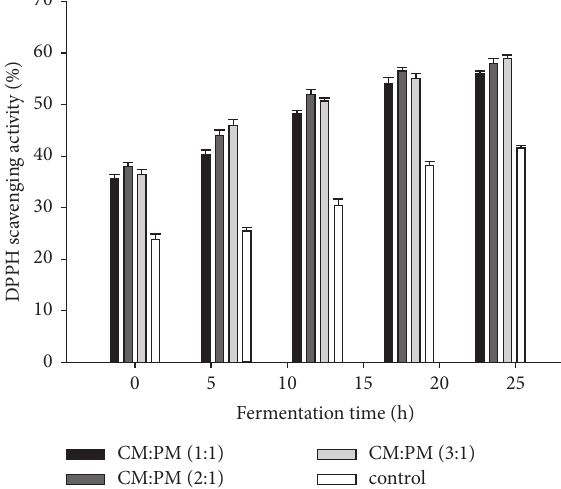
Figure 5: DPPH free radical scavenging rate of four samples at different fermentation times. All the values are expressed as mean ± SD ( n � 3). CM, cowpea milk; PM, peanut